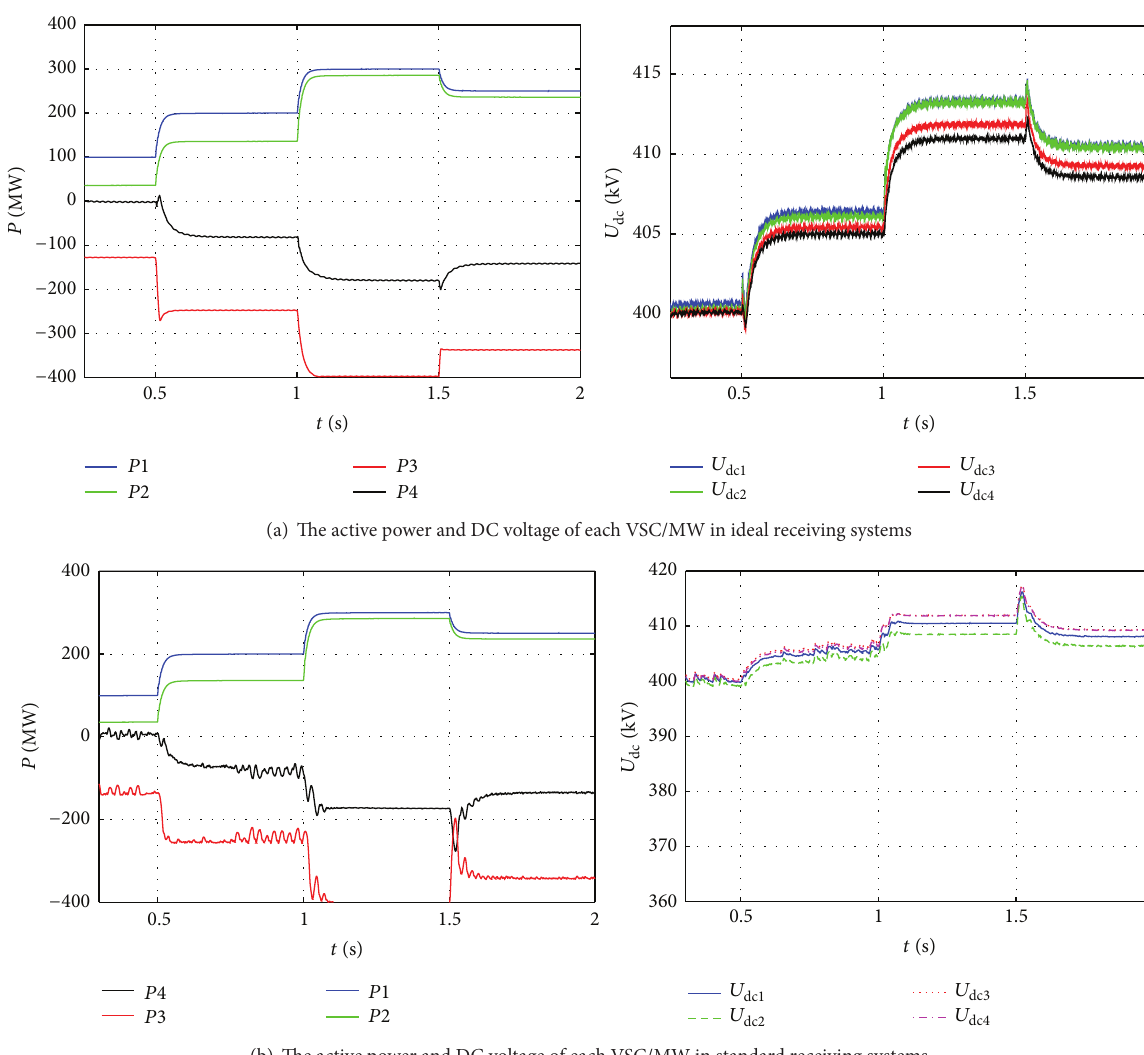
Figure 7: Simulation of variation of power of wind farm with standard receiving